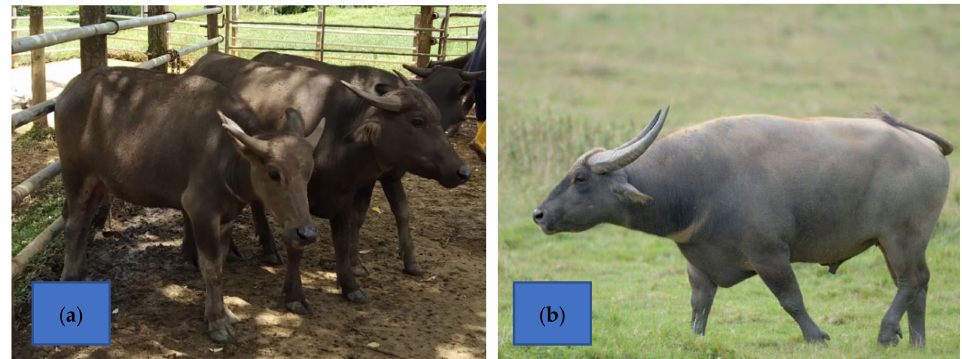
Figure 1. The swamp buffaloes. ( a ) Calves Swamp buffalo, ( b ) adult Swamp buffalo. Reprinted with permission from ref. [21]. Copyright 2021 Mohd Azmi et